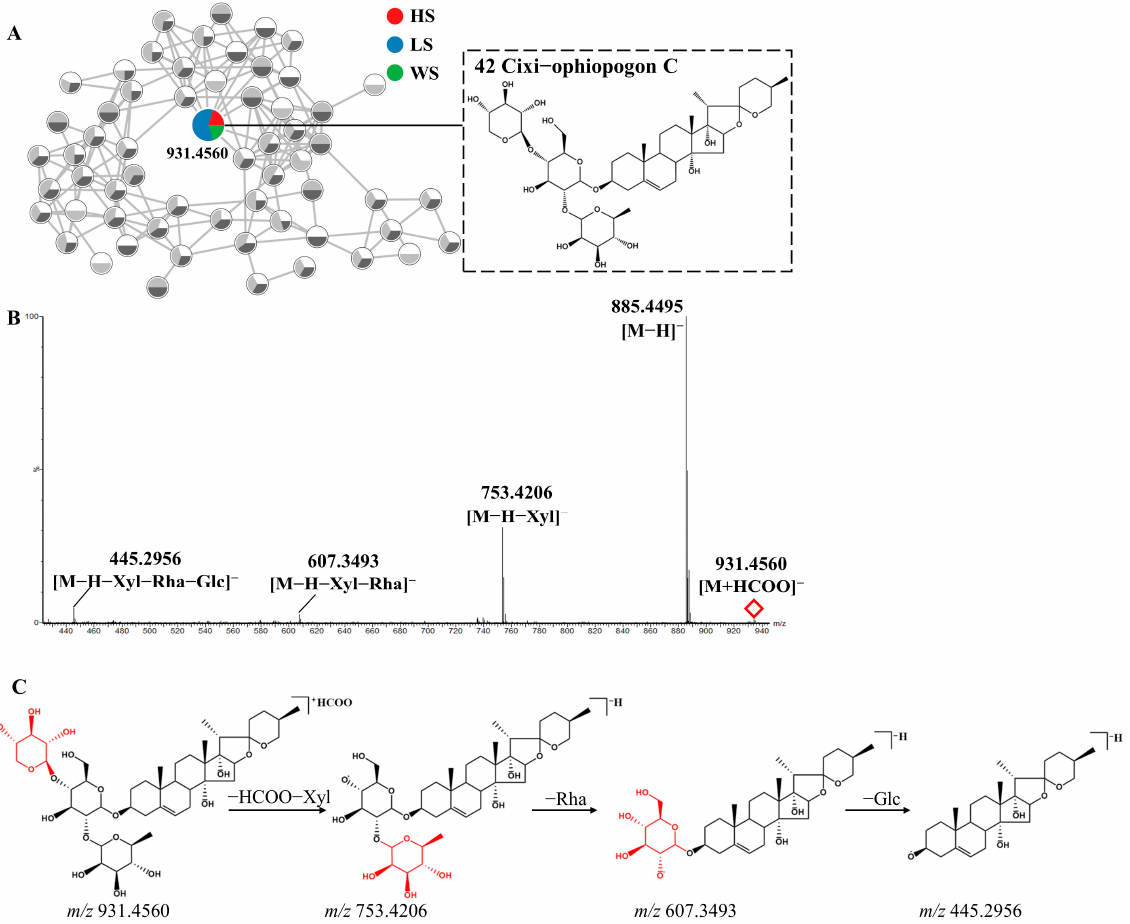
Figure 3. The enlargement of cluster I molecular network ( A ), MS/MS spectra ( B ) and possible fragmentation pathway( C ) of Cixi-ophiopogon C (Compound 42 ) from MD in negative ion mode.